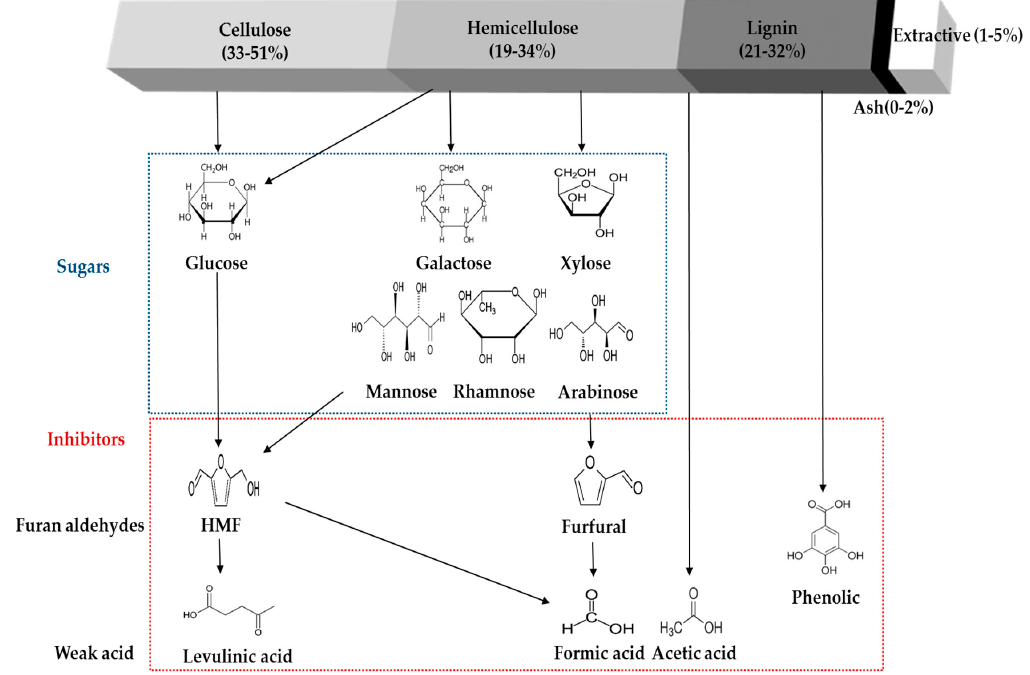
Figure 1. The average chemical composition of lignocellulosic materials and brief scheme of main inhibitory compounds formation.